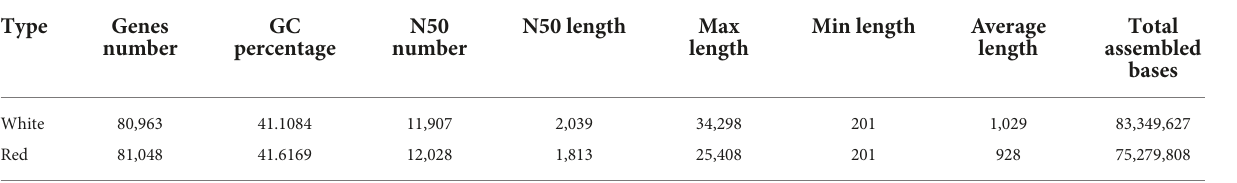
( Supplementary Figure 1 ). The specific top 20 GO terms for each comparison are shown in Supplementary Figure 2 .